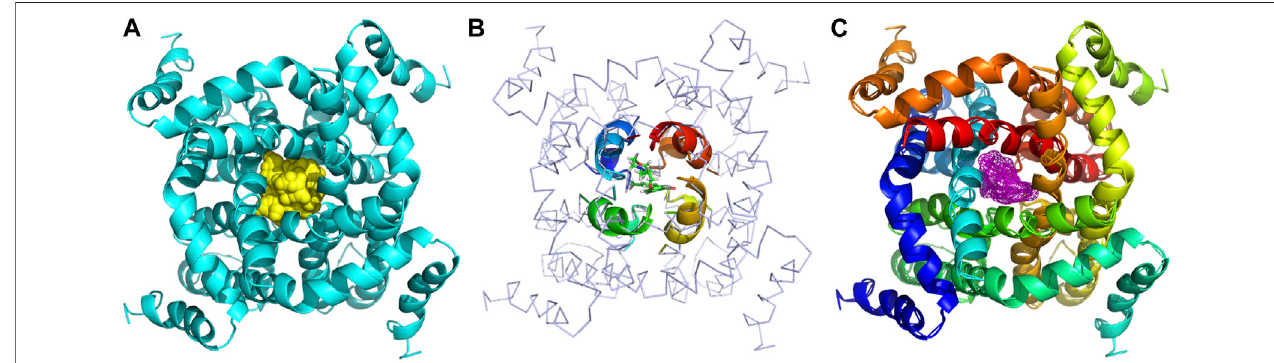
FIGURE 3 | Simulated 3D complex structure of compound T11 with its target Kv1.5 channel using Sur fl ex Docking. (A) Kv1.5 channel was shown as a tetramer colored in cyan, and the binding site in the center was shown in the surface colored in yellow. (B) Binding site of the Kv1.5 channel was shown in the rainbow cartoon. Compound T11 wasshown inthegreen andwhitesticksituatedinthecenterofthechannel site. (C) Kv1.5 channelwasshown intherainbowcartoon.Compound T11 in the center of the Kv1.5 channel site was shown in the magenta